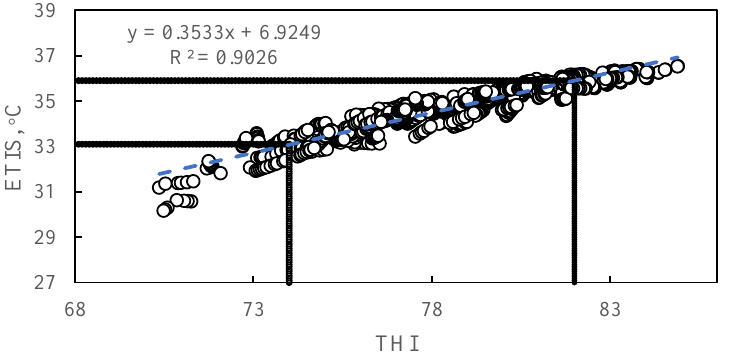
Figure 7. Regression on temperature and humidity index versus equivalent temperature index for sows. The dots represent the scatter plot of the ETIS corresponding to the THI. The dotted line represents model estimate based on linear regression of ETIS with THI. The linear regression equation here is: y = 0.3533x + 6.9249 (where y stands for ETIS ( ◦ C) and x stands for THI) (R 2 = 0.9026, p < 0.0001). Table 2. ETIS heat stress threshold. Threshold distribution of ETIS was determined according to the threshold distribution of THI and the correlation equation between THI and ETIS.